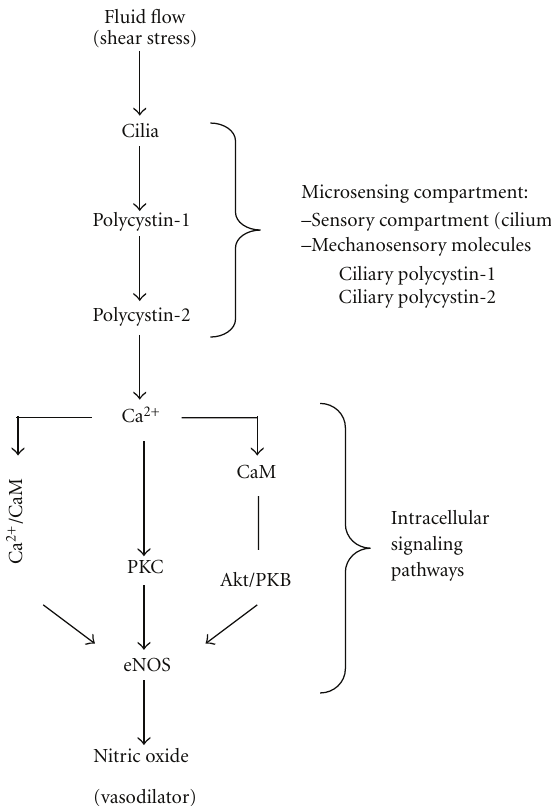
Figure 1: Mechanosensory cilia as microcompartments.